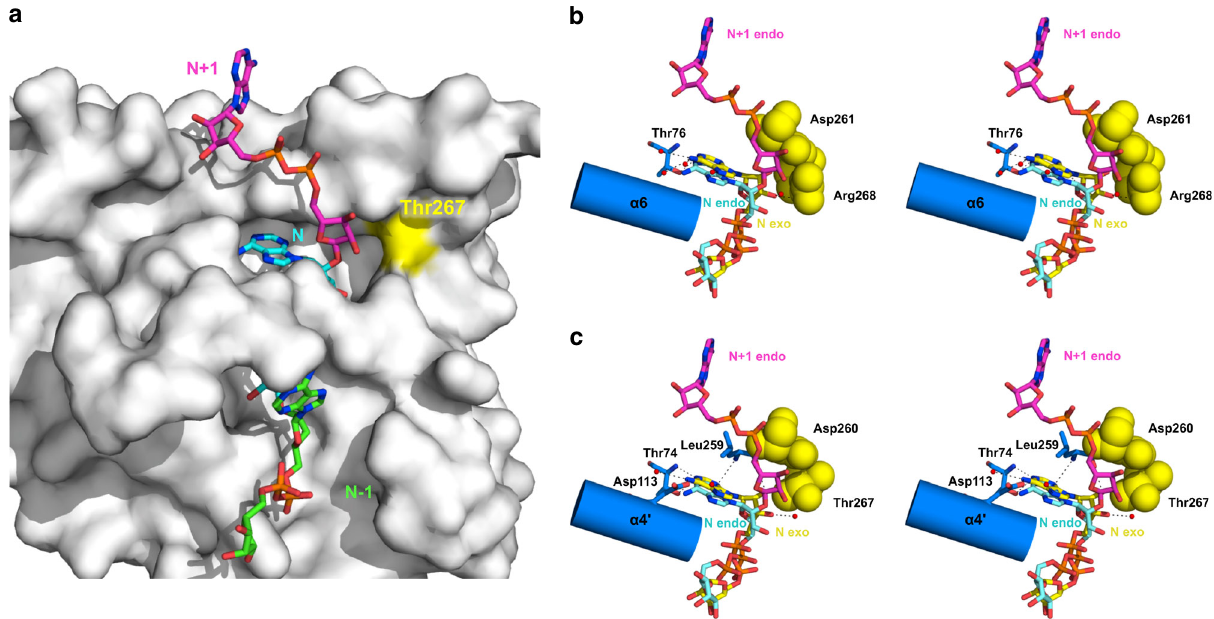
Fig. 4 Structural model of DrPARG-PAR (poly-ADP-ribose) complex in endo-glycohydrolase mode. a Solvent-accessible surface of DrPARG in gray (position of Thr267 is in yellow) with a PAR 3 modeled in an endo-glycohydrolase position. Carbons of the three individual ADP-ribose units are distinctly colored. b , c Stereo images of an overlay of the modeled endo-glycohydrolase PAR 3 (colored the same as in a ) with the b obligate exo-glycohydrolase PARG structures in complex with ADP-ribose from Thermomonospora curvata (TcPARG) structure and c observed exo-glycohydrolase DrPARG structure. Residues and secondary structures implicated in steric hindrance with n + 1 and n ADP-ribose units of TcPARG as well as their equivalents of DrPARG are shown as spheres (colored yellow) and a cartoon model, respectively. The hydrogen network between the adenine moiety/ribose ′ of the n ADP-ribose unit and the protein/crystallized water observed for the exo-glycohydrolase mode is shown as dashed lines